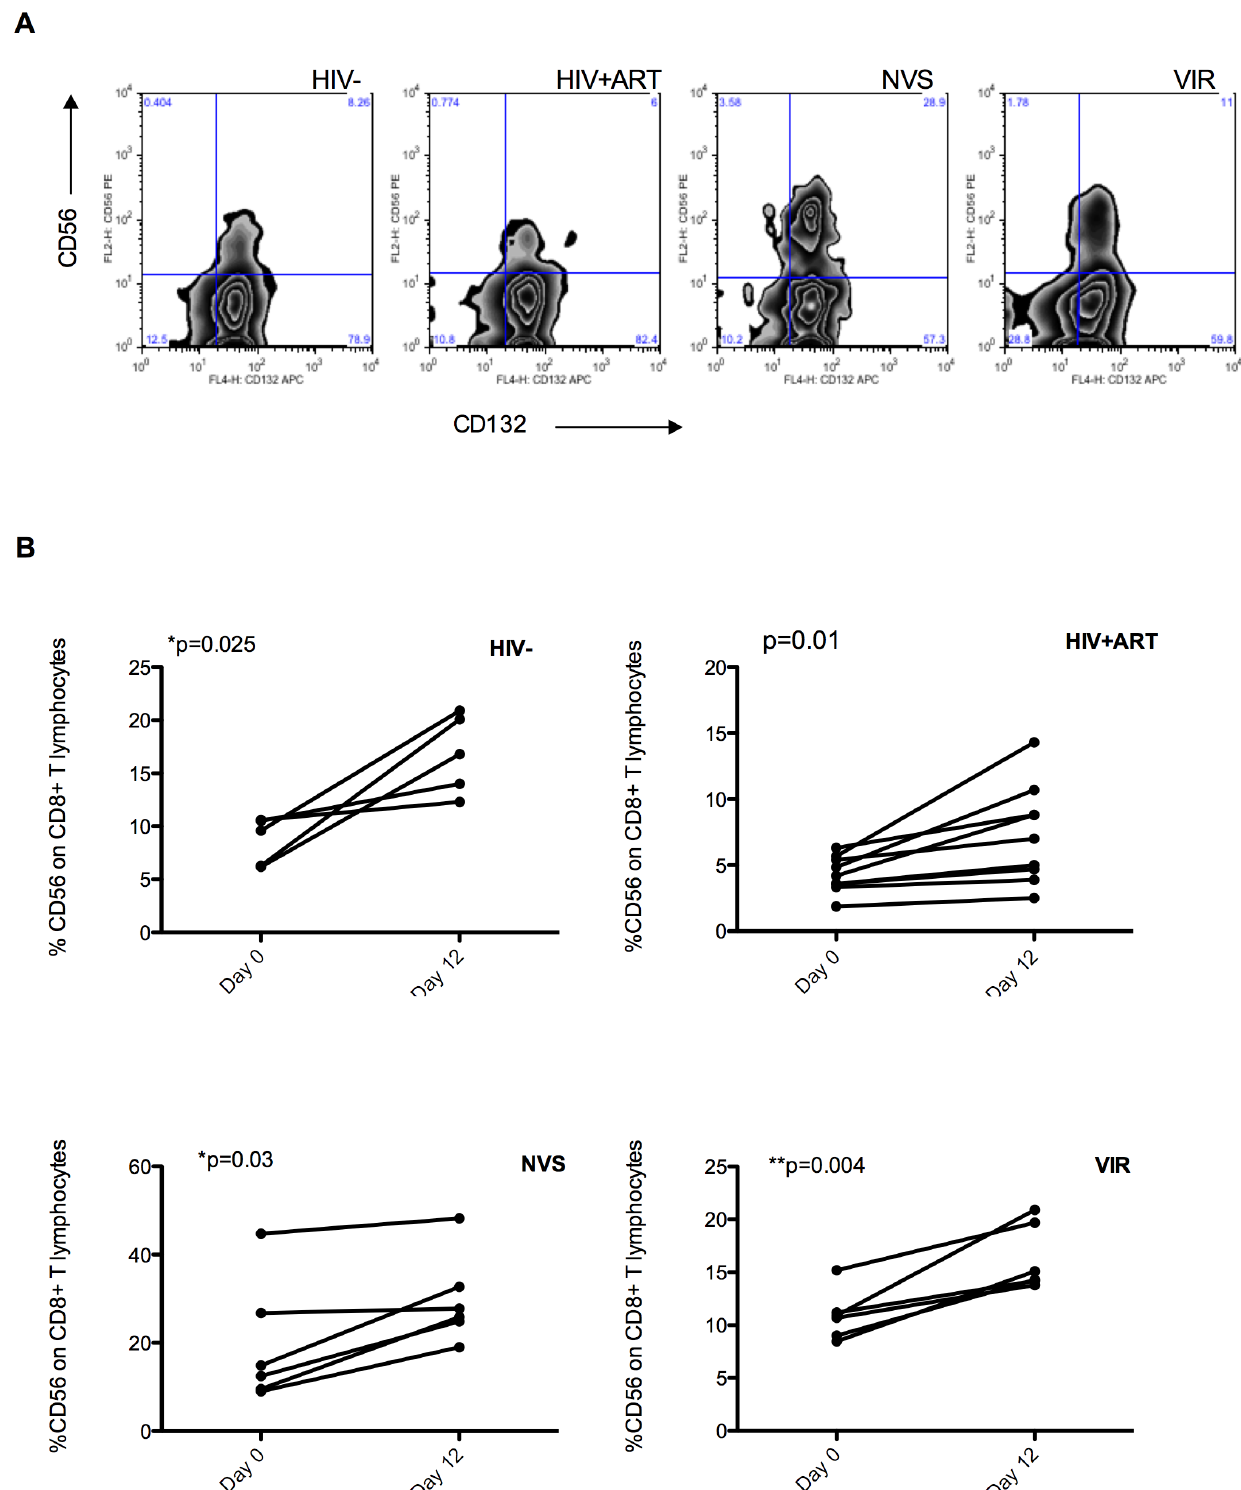
Figure 5. IL-15 restores CD56 on CD8 T cells from HIV infected patients. (A) Most CD8 T cells and almost all CD56 + CD8 T cells express the common gamma chain ( c c ) (or CD132). Representative plots (from left ND, PD, NVS, VIR) show there was no significant downregulation of this receptor on CD8 T lymphocytes from any infected group (B) Culture of PMBC in IL-15 resulted in a significant upregulation of CD56 on CD8 T lymphocytes at day 12 relative to start of culture in infected and uninfected samples.